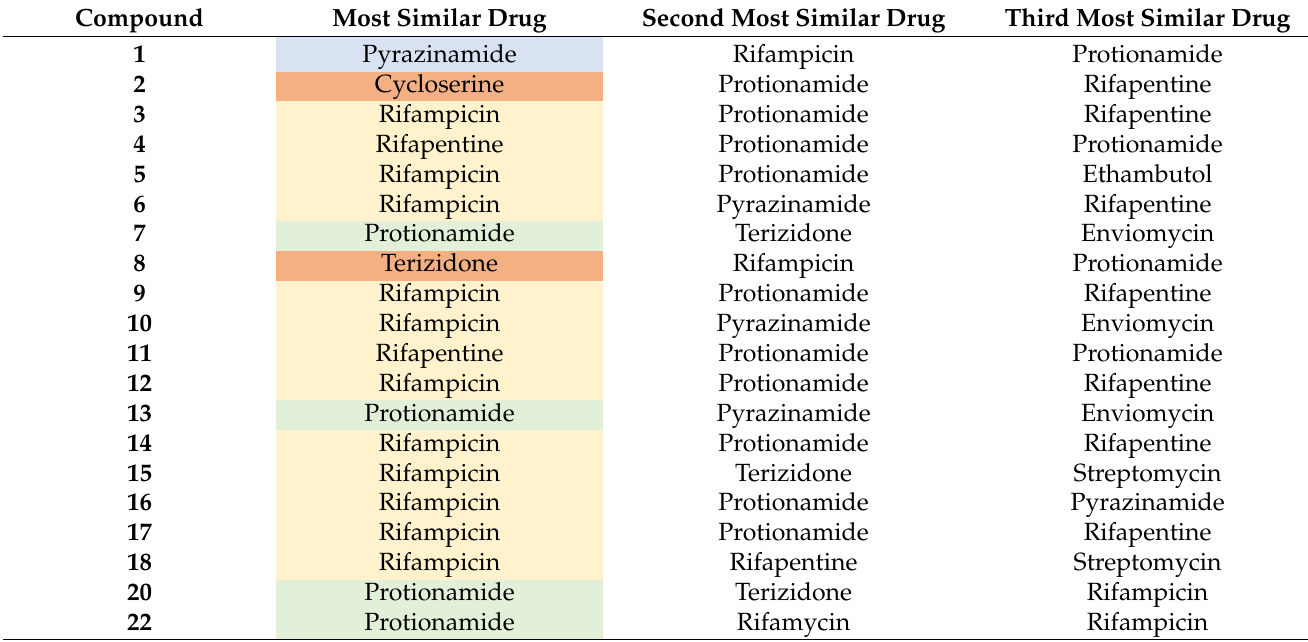
Table 2. The average score (after normalization) of mutual information values between each tested compound and the anti-TB drugs. The last three columns present the most similar approved anti-TB drugs with the subjected compounds (i.e., the approved anti-TB drug having the highest mutual information with an assessed compound). Compounds in the “Most similar drug” column are highlighted based on their chemical